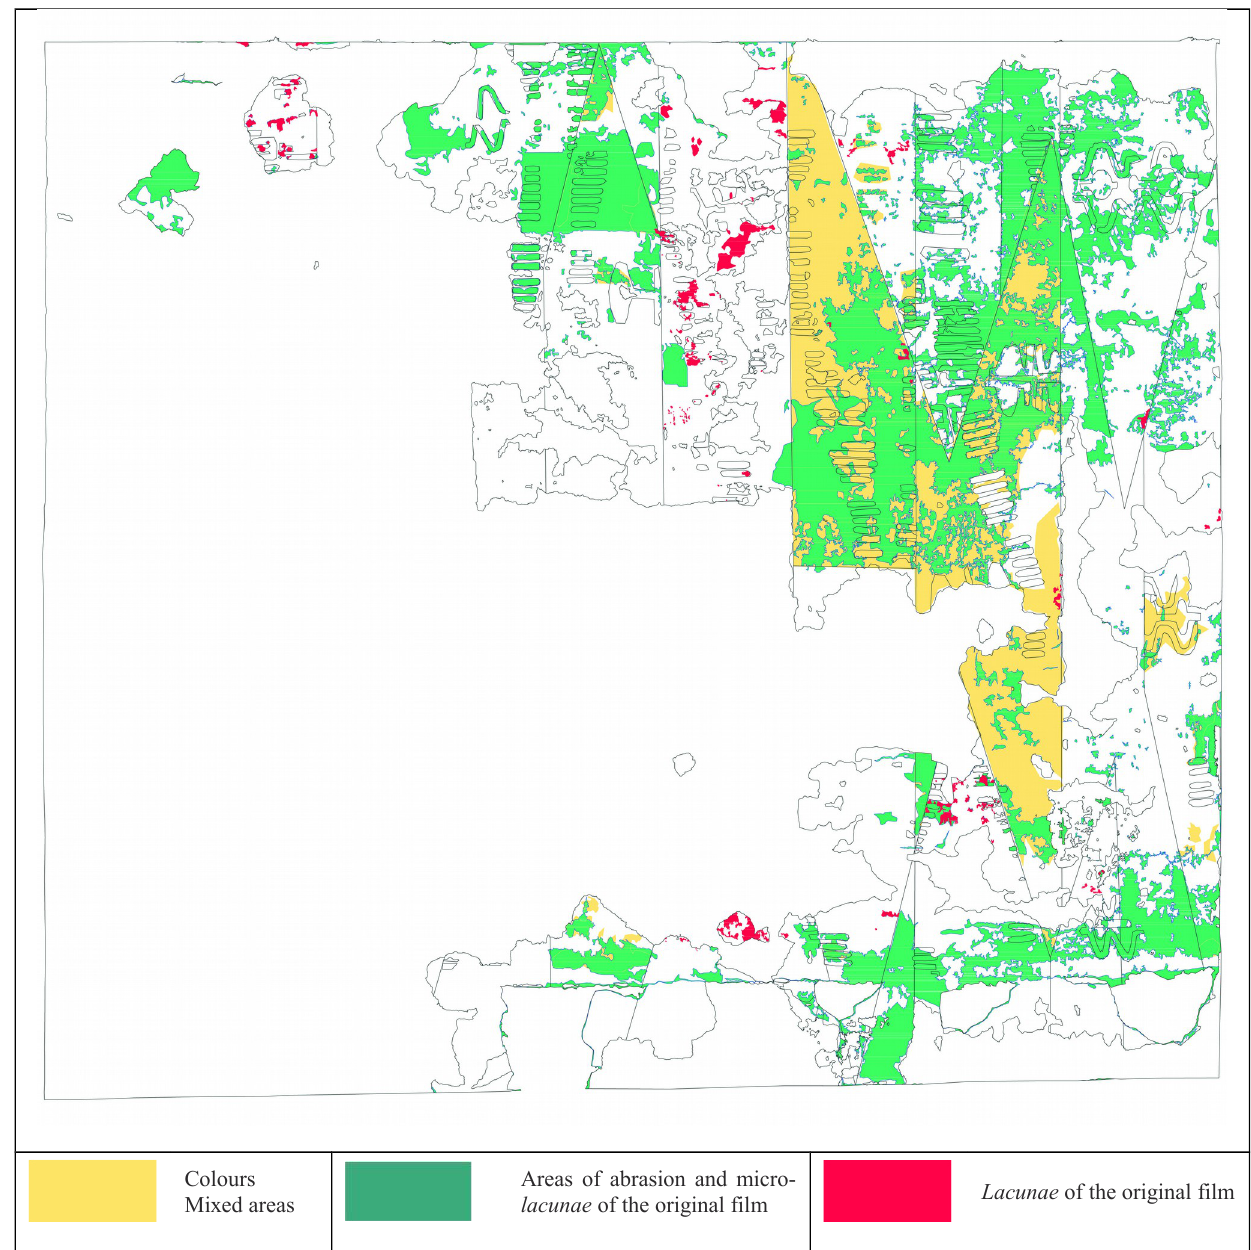
Figure 4 . Thematic graphic table of the State of Conservation (B) and its legend. Image: Paola Mezzadri all rights